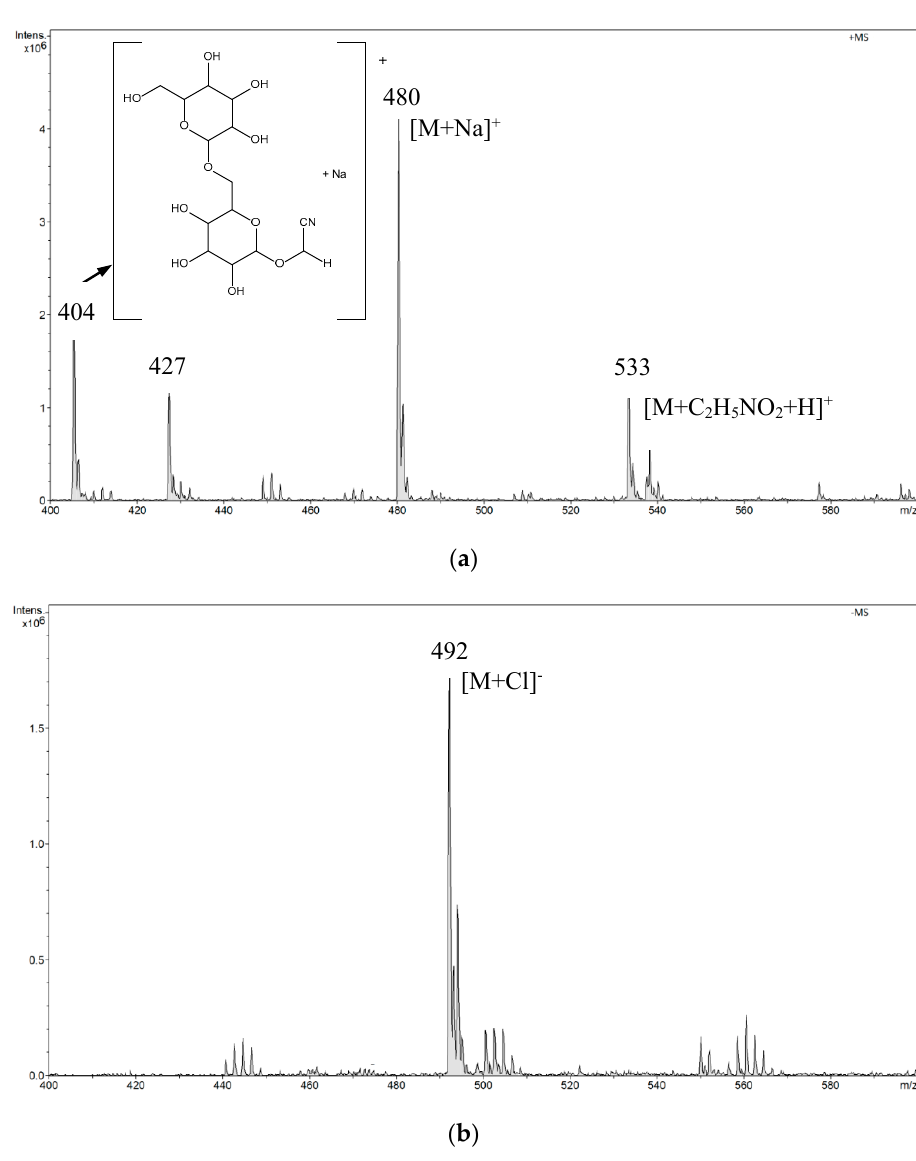
Figure 5. The ESI-MS spectrum of amygdalin performed in a buffer solution of pH 2.0 (hydrochloric acid, sodium chloride, and aminoacetic acid): ( a ) positive mode, ( b ) negative mode. In the positive mode ESI-MS spectrum for amygdalin in a buffer solution of pH 10.0, we observed two low-intensity signals m / z 480 [M + Na] + and m / z 496 [M + K] + and two signals from the fragmentation ions ( m / z 427 and m / z 443). The structure of the fragmentation ion m / z 443 is shown in the spectrum in Figure 6a. In the negative mode ESI-MS spectrum, we observed only one signal m / z 492 [M + Cl] − (Figure 6b).